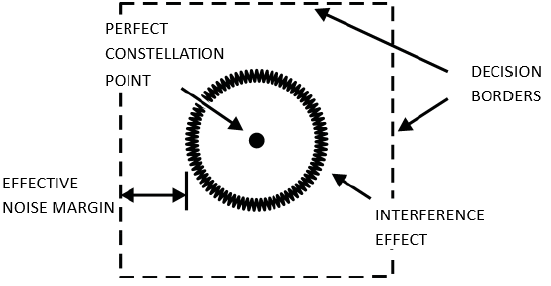
Figure 3. Superposing a narrow-band interfering signal on the information-carrying one.